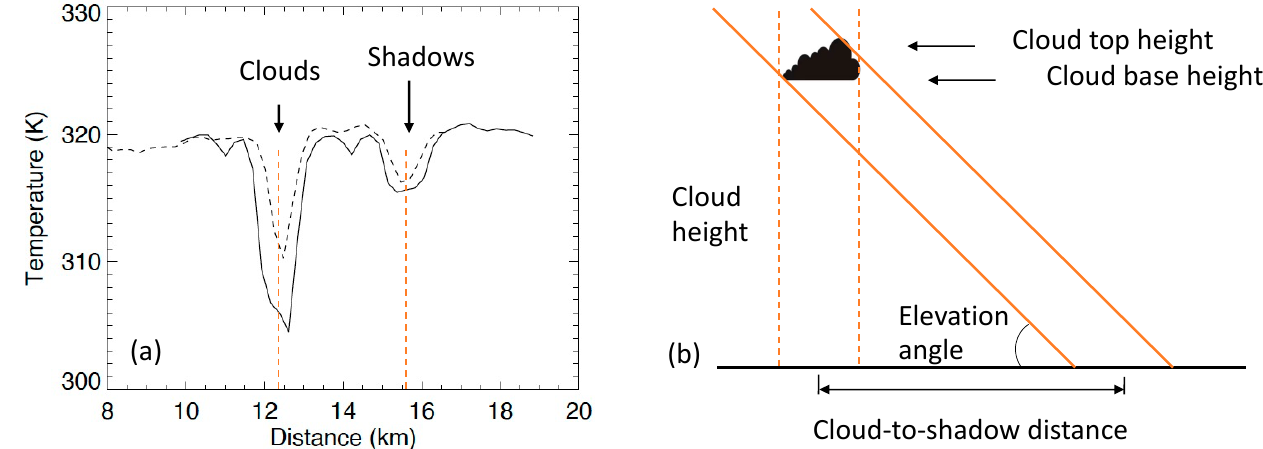
Figure 10. ( a ) Cross-section of the PBL clouds and shadows in area “A”, with the second cloud shifted to compare with the first cloud. ( b ) A schematic diagram of cloud-to-shadow distance with respect to cloud top and base height (CTH and CBH). The Sun’s elevation angle was 55.9 ° at this hour. The cloud-to-shadow distance derived from the CTI image was ~3.3 km, and the estimated CBH was 4.9 km.